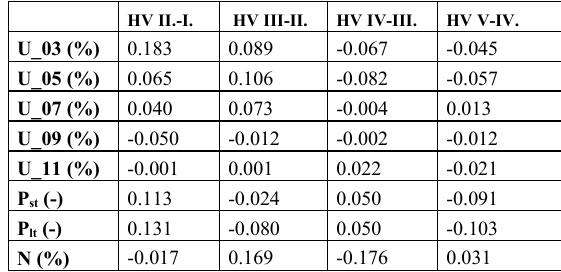
T RENDS OF CHANGES IN THE SELECTED VOLTAGE QUALITY PARAMETERS IN THE HV NETWORKS HV